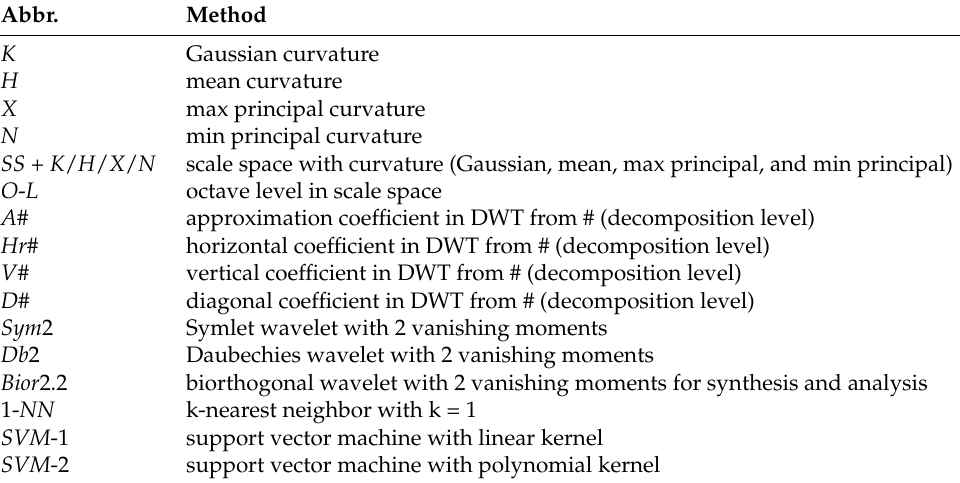
Table 2. The list of abbreviations in this research.